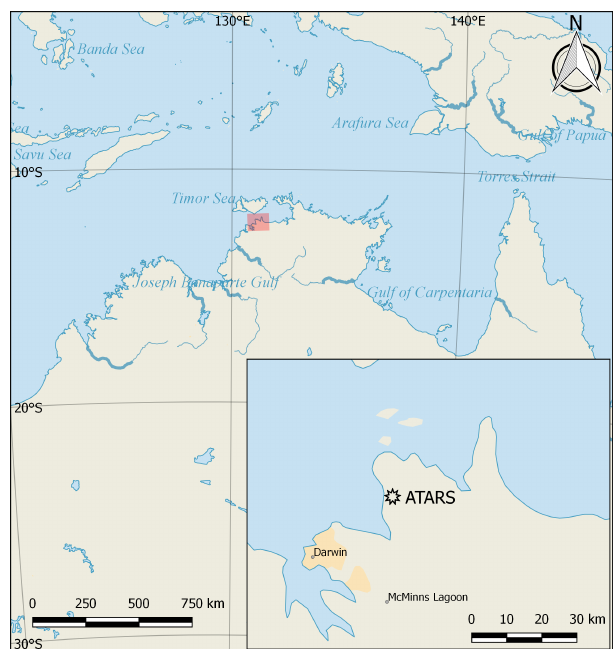
Figure 1. Map of region surrounding ATARS. Composed in QGIS using Natural Earth